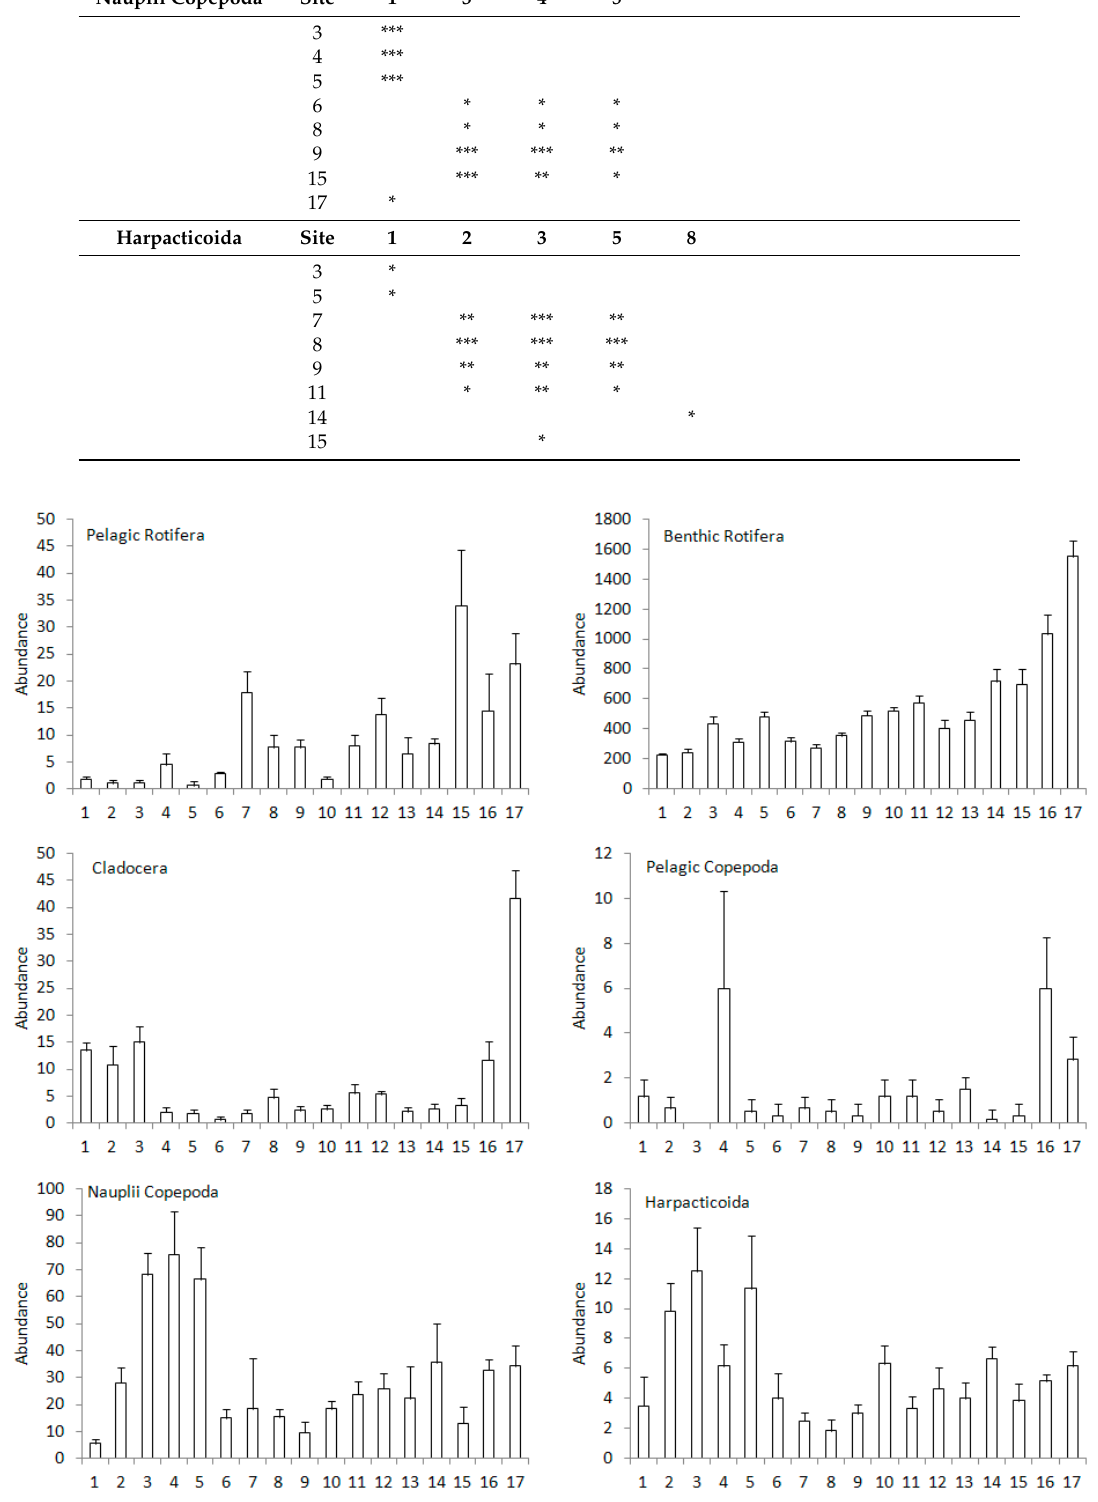
Figure 5. Mean + SD of abundance (ind. 100 L − 1 ) of the zooplankton groups in the examined sites of the Corgo river. Table 5. Significant differences ( p –values) in zooplankton abundance between the examined sites.